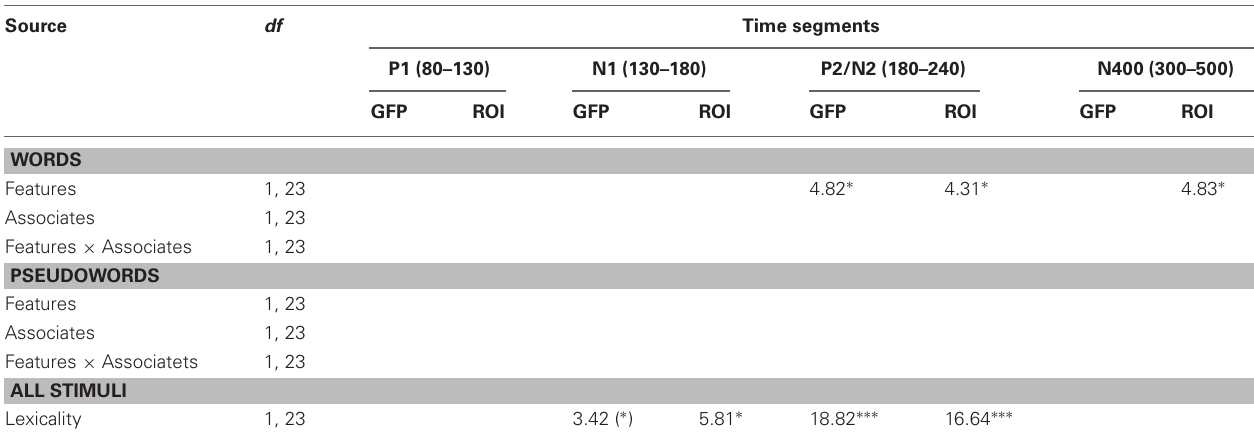
Table 2 | F -values and significance levels from analyses of variance on GFP amplitudes and on ERP amplitudes at relevant electrode sites (ROIs; see Methods and Results for